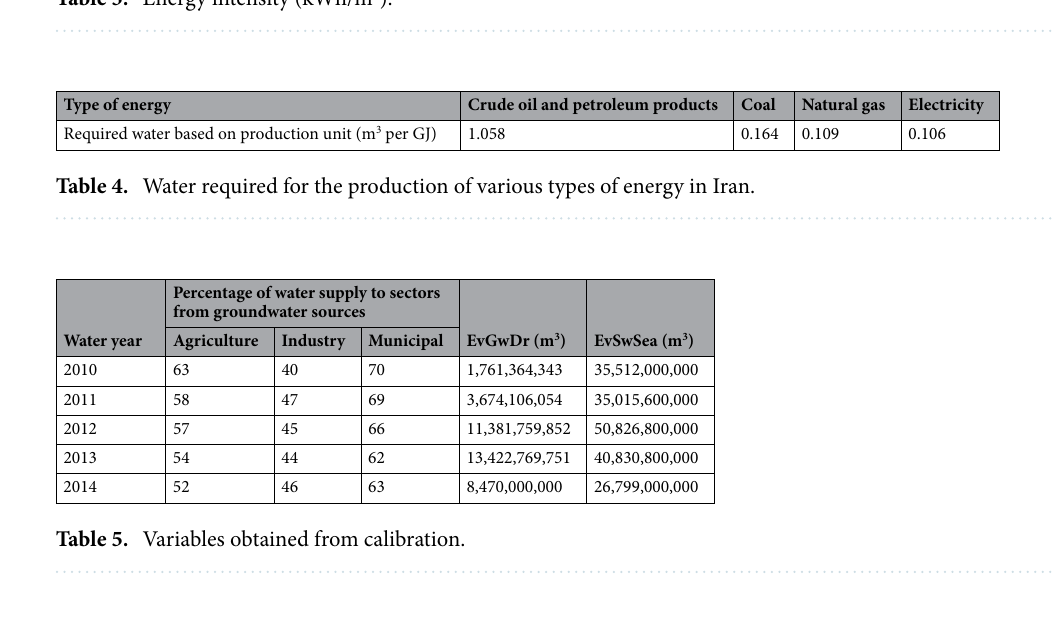
Table 3. Energy intensity (kWh/m 3 ).